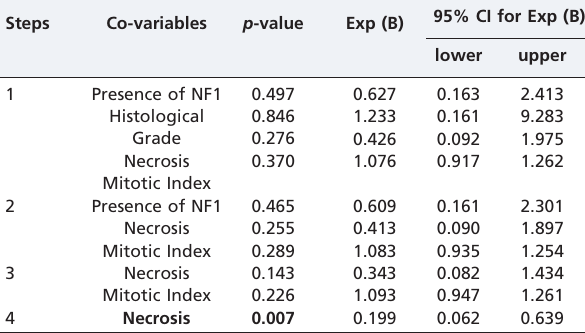
Table 5 - Results of the Cox regression model for significant variables in the univariate analysis of overall